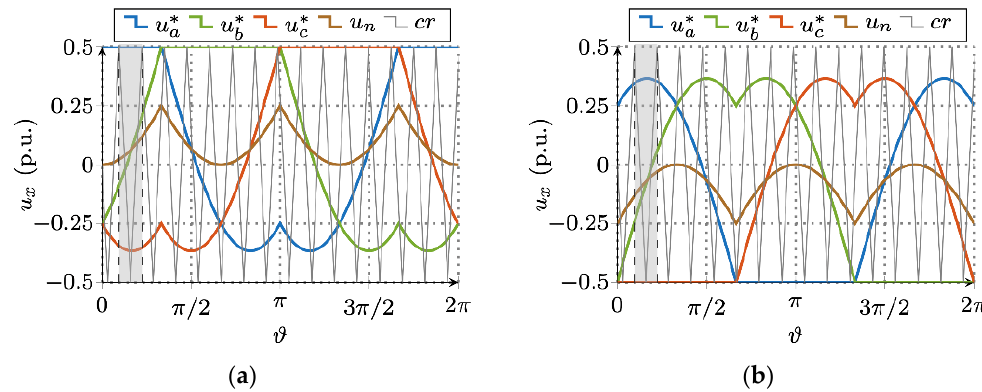
Figure 3. Phase ( u * ) and neutral ( u n ) modulating signals for: ( a ) DPWMMAX; and ( b )